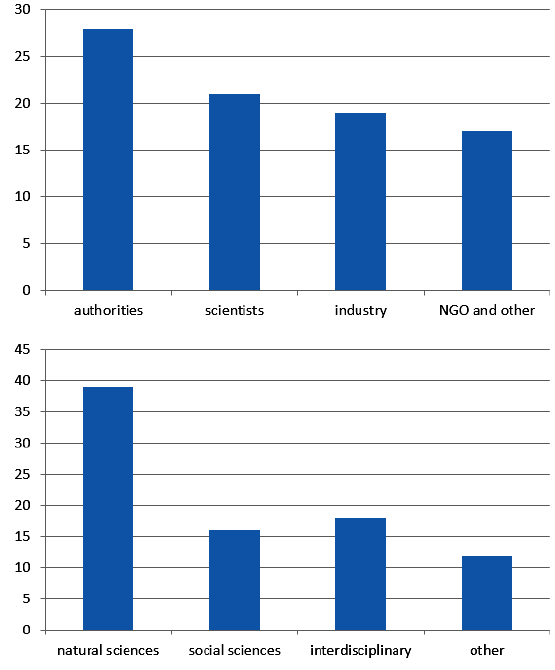
Fig. 2 . Number of stakeholders per professional background (stakeholder group) and educational